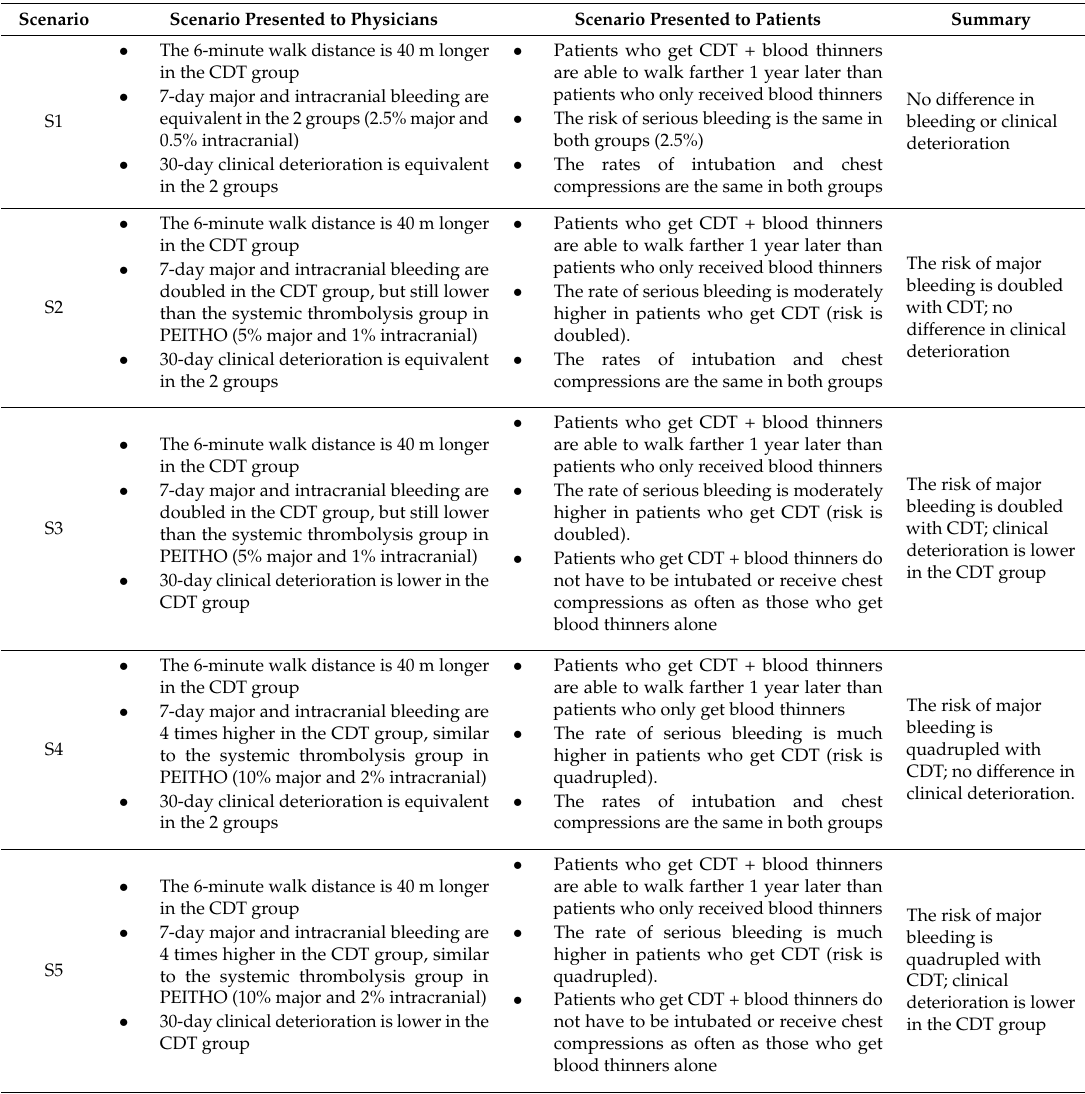
Table 1. Scenarios presented to physicians and